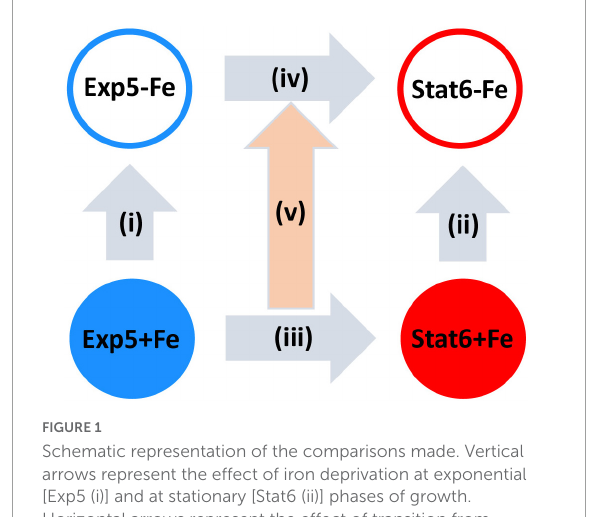
FIGURE1 Schematic representation of the comparisons made. Vertical arrows represent the effect of iron deprivation at exponential [Exp5 (i)] and at stationary [Stat6 (ii)] phases of growth. Horizontal arrows represent the effect of transition from exponential (Exp5) to stationary (Stat6) phases of growth with (iii) and without (iv) iron. The central arrow represents the second order contrast on the interaction of growth arrest with iron availability (v). Exp5+Fe, exponential culture with iron; Exp5–Fe, exponential culture without iron; Stat6+Fe, stationary culture with iron; Stat6–Fe, stationary culture without iron.